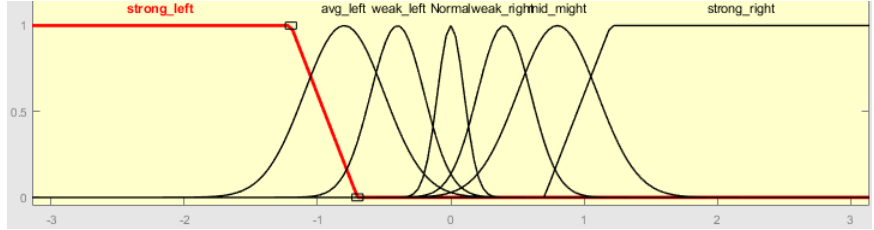
Fig. 4. Member function for the angle of deviation Q (input)